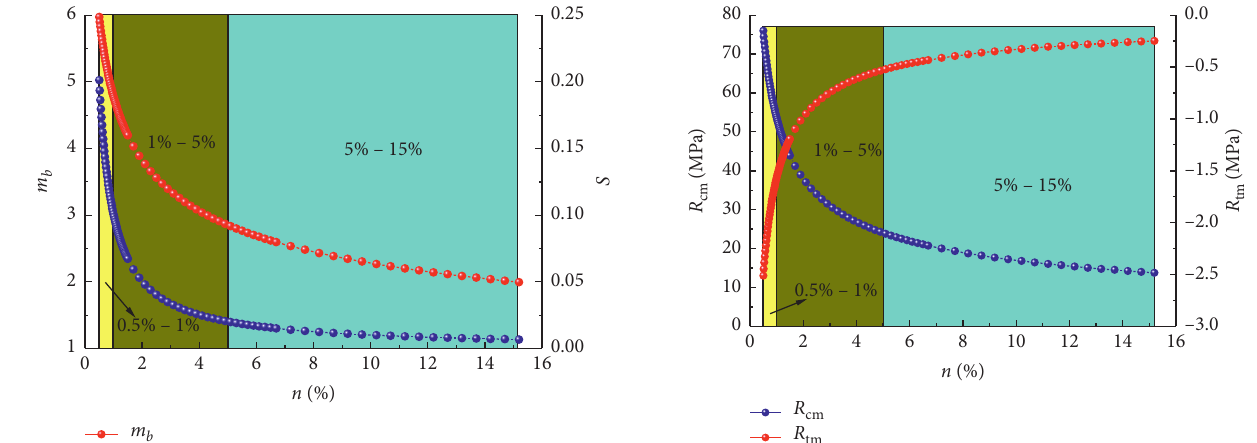
Figure 6: The change curve of m